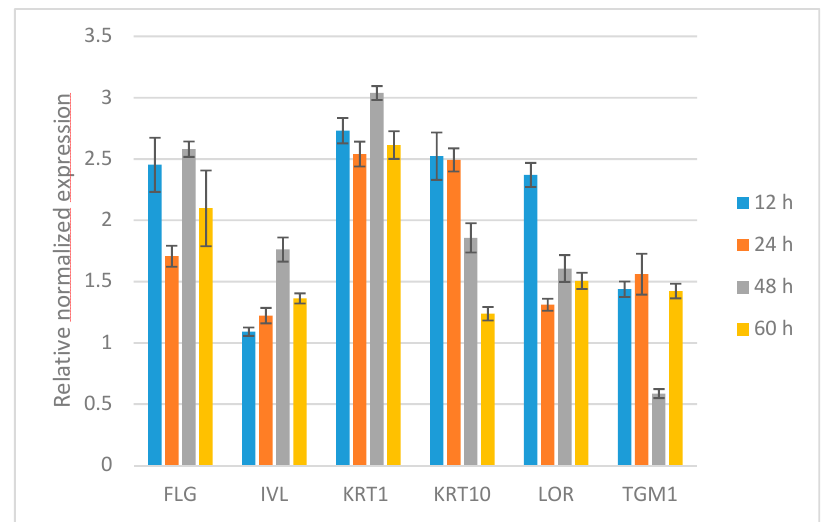
Figure 4. Influence of γ -PSL (100 μ g/mL) on the relative, normalized gene expression of differentiation specific marker genes in NHEKs by time dependent qPCR over 12–60 h. FLG: filaggrin, IVL: Involucrin, KRT1: Cytokeratin 1, KRT10: Cytokeratin 10, LOR: Loricrin, and TGM1: Transglutaminase 1. Relative, normalized expression, related to the untreated control (expression = 1).